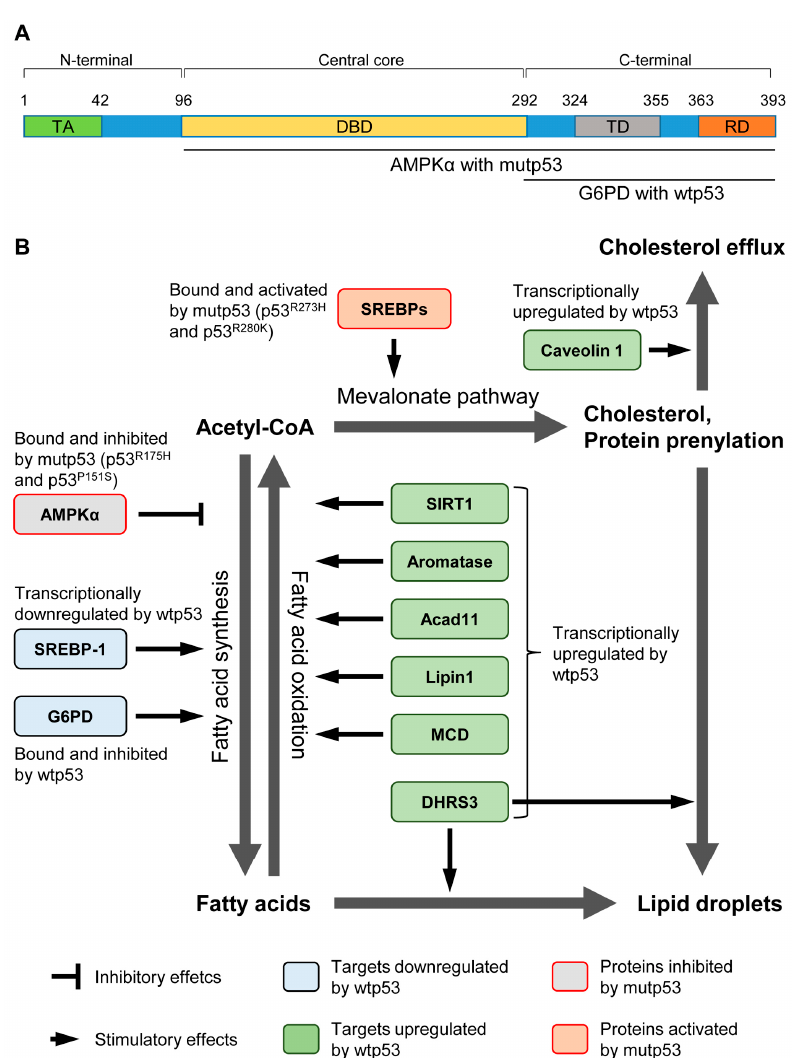
Figure 1. Regulation of lipid metabolism by wild-type and mutant p53. ( A ) Schematic representation of functional domains in p53 and regions which interact with G6PD and AMPK α . TA: